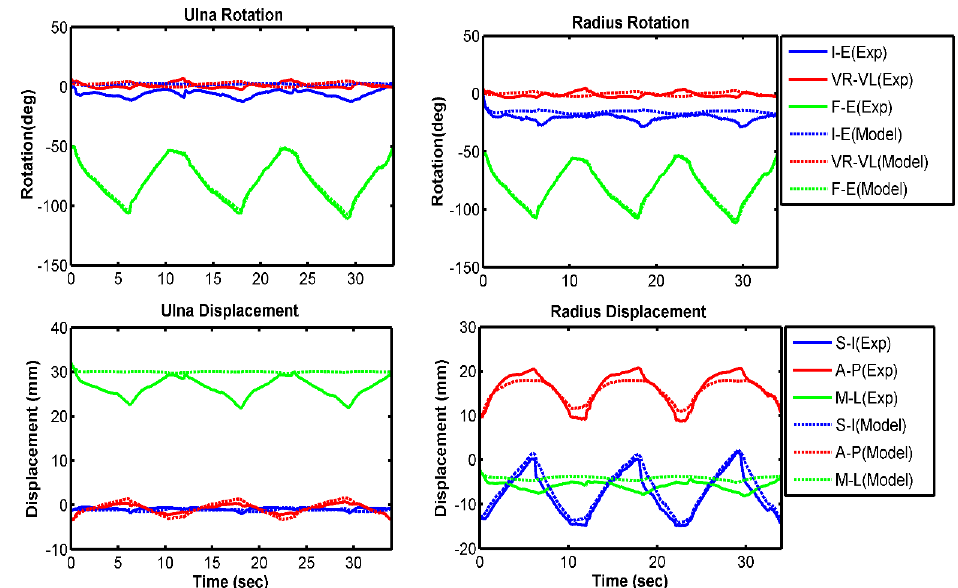
Figure 4. Comparison of bone kinematics between experiment and model prediction for 10 deg/s trial. Increasing trend of the graph indicates more internal rotation for I–E, more valgus rotation for VR–VL, and more extension for F–E. Similarly, it indicates more superior translation for S–I, more anterior translation for A–P, and more medial translation for M–L. Decreasing trend of the graph indicates the opposite.